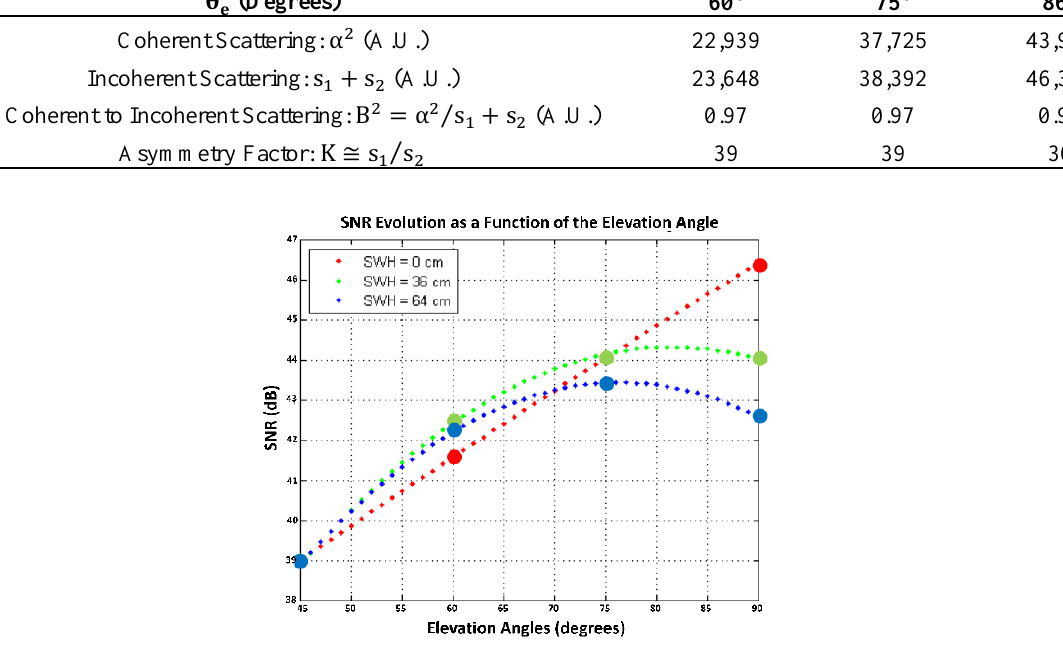
Figure 13. Scattered field complex plane representation for a SWH = 36 cm at an elevation angle of θ = 60° ( a ), 75° ( b ) and 86° ( c ). e Table 4. Statistical analysis of the complex field distribution of the scattered GPS signals after retracking, over the CIEM wave channel at different elevation angles: θ (Degrees) 𝛉 𝐞